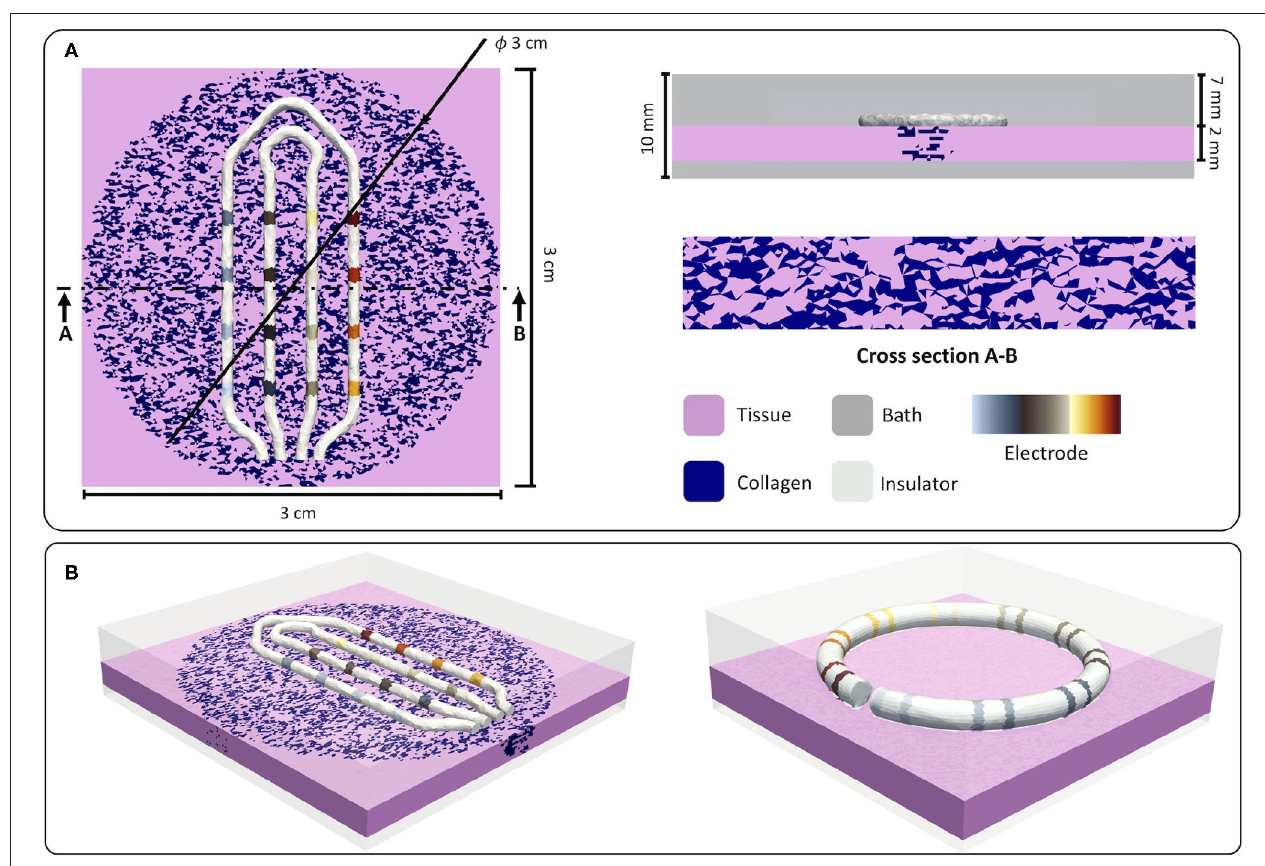
FIGURE 1 | (A) Dimensions of the in silico setup. Tissue dimensions, catheter position, and fibrotic dimensions are shown in the left panel. In the top right corner, bath dimensions are depicted. A cross-section cut showing the interstitial model is depicted in the lower right corner. (B) Isometric view of the two setups used for the in silico experiments. The left panel shows the setup using the HD Grid catheter (St. Jude Medical, EnSite HD Grid catheter, St. Paul, MN) and the fibrotic tissue. The right panel shows the setup using the Lasso catheter (Biosense Webster, Diamond Bar, CA, USA) on top of the tissue. Reused from Sánchez et al.